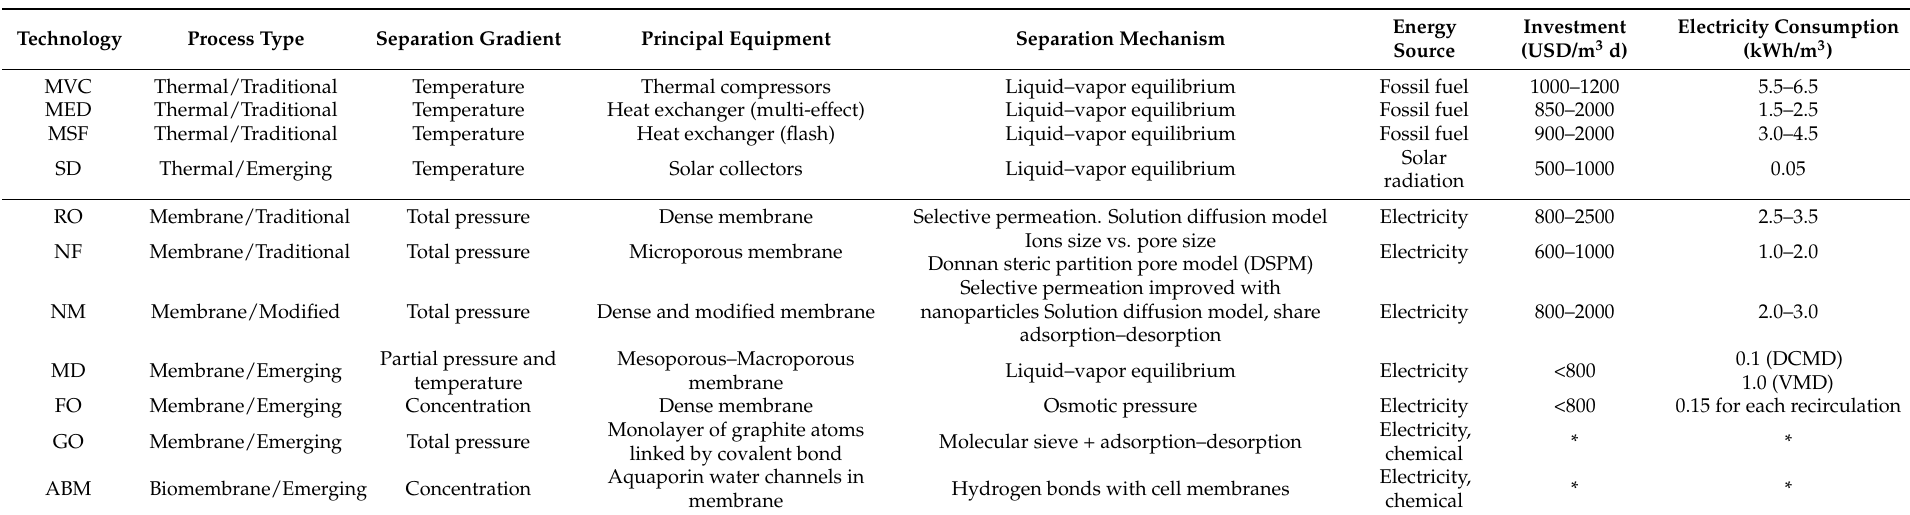
Table 4. Summary of desalination technology characteristics (part